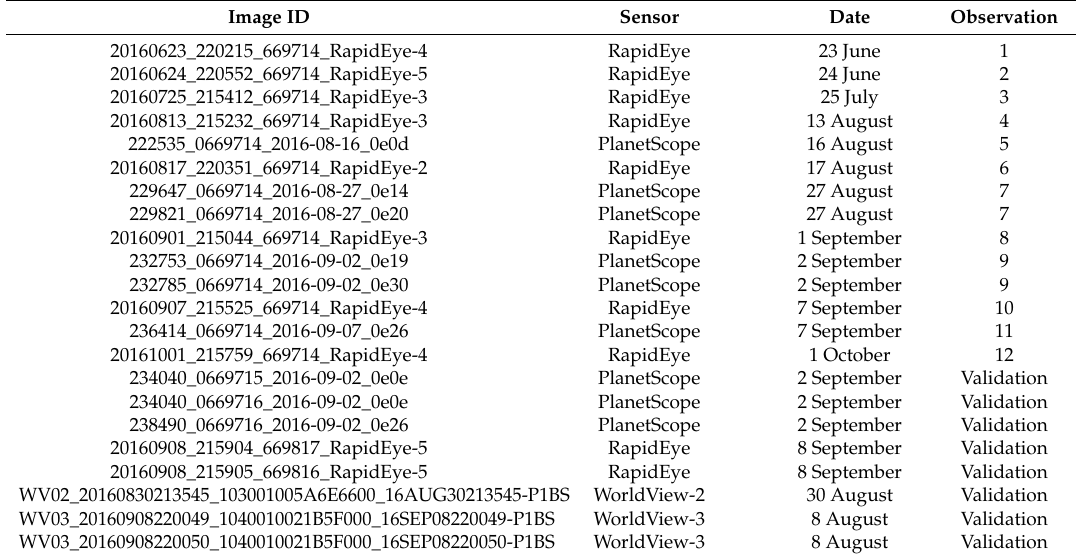
Table 2. List of